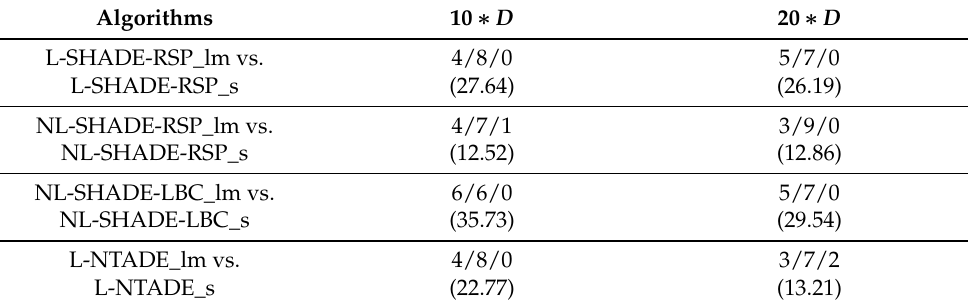
Table 6. Algorithms with crossover rate sorting and biased Lehmer mean, CEC 2022, Mann–Whitney tests and total standard